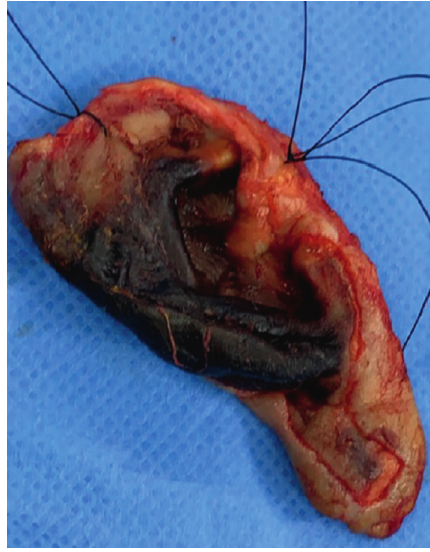
Figure 7: Necrotic right ear auricle after